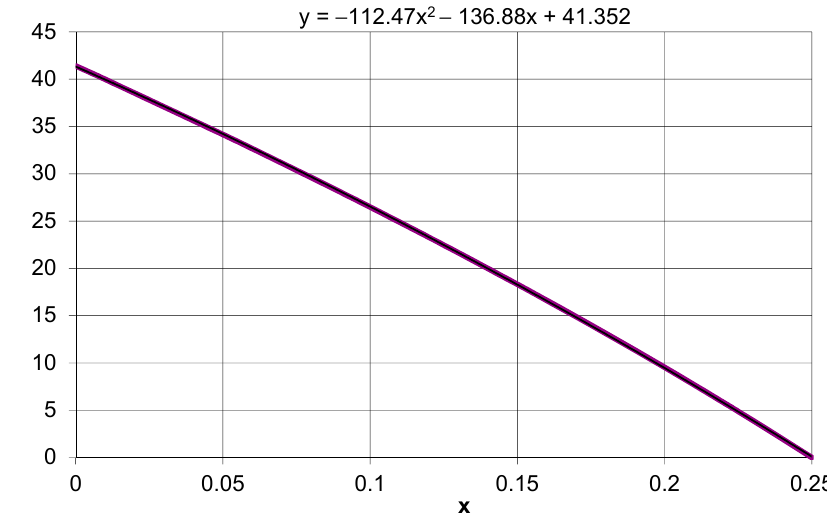
Figure 7. Expansion of the tubular structure along the diameter moving from closed to the open position.